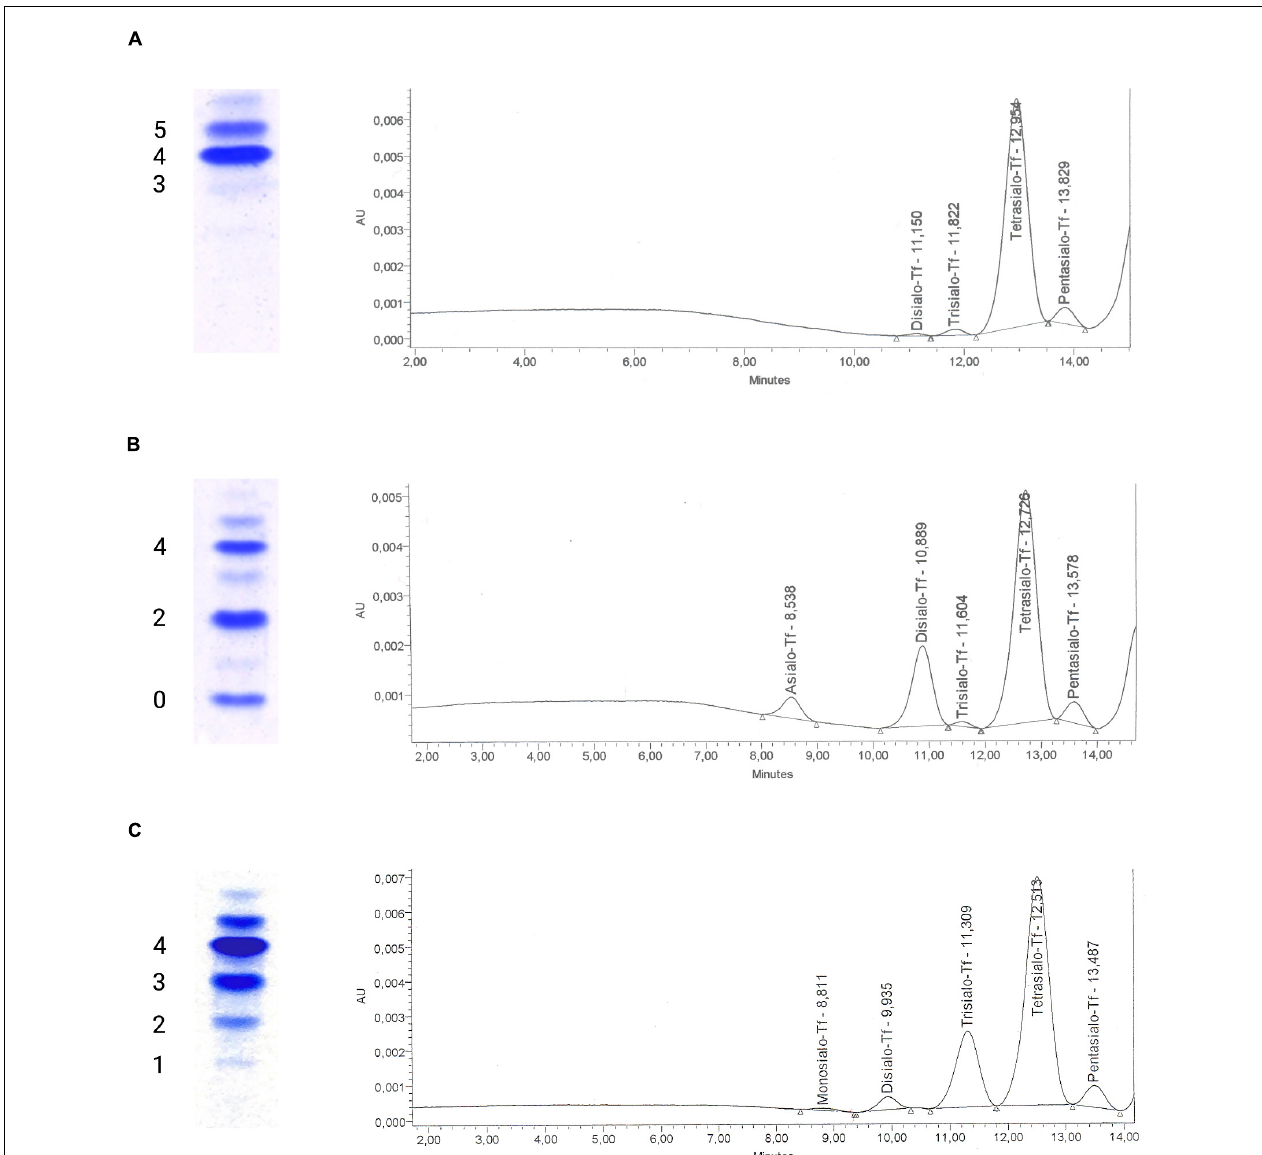
FIGURE 1 | Glycosylation analysis of serum transferrin using isoelectric focusing and high-performance liquid chromatography. Isoelectric focusing (IEF) of serum transferrin has traditionally been used to diagnose congenital disorders of N -glycosylation. The test separates transferrin isoforms according to their negative charge that is dependent on the amount of sialic acid residues on glycan chains, with each sialic acid residue corresponding to a negative charge. Currently, alternative methods such as high-performance liquid chromatography (HPLC) are being favored for their ease of use and ability to generate quantitative results for transferrin isoforms. (A) A normal glycosylation profile in IEF of serum transferrin with tetrasialo-transferrin (4-) representing the major fraction of transferrin isoforms. To the right, the corresponding HPLC curve can be seen, giving the area % for the varying transferrin subtypes (pentasialo-transferrin 4.97%, tetrasialo-transferrin 92.44%, trisialo-transferrin 1.94%, and disialo-transferrin 0.65%). (B) Impaired transferrin glycosylation seen in a PMM2-CDG patient, with decreased tetrasialo-transferrin and increased di-(2-) and monosialo-(1-)transferrin proportions (type I CDG pattern). HPLC identified pentasialo-transferrin (4.62%), tetrasialo-transferrin (68.02%), trisialo-transferrin (0.89%), disialo-transferrin (21.36%), and asialo-transferrin (5.1%). (C) In a COG6-CDG patient, increased proportions of tri- (3-), di- (2-), and monosialo-transferrin (1-) are seen in IEF. HPLC detected pentasialo-transferrin (5.2%), tetrasialo-transferrin (69.16%), trisialo-transferrin (22.03%), disialo-transferrin (2.99%), and monosialo-transferrin (0.62%). Reference intervals for HPLC of serum transferrin at our laboratory: Pentasialo (5-) 2.6–10.2%, tetrasialo (4-) 85.7–94.0%, trisialo (3-) 1.16–6.36%, disialo (2-) 0.38–1.82%, monosialo (1-) 0%, asialo (0-)